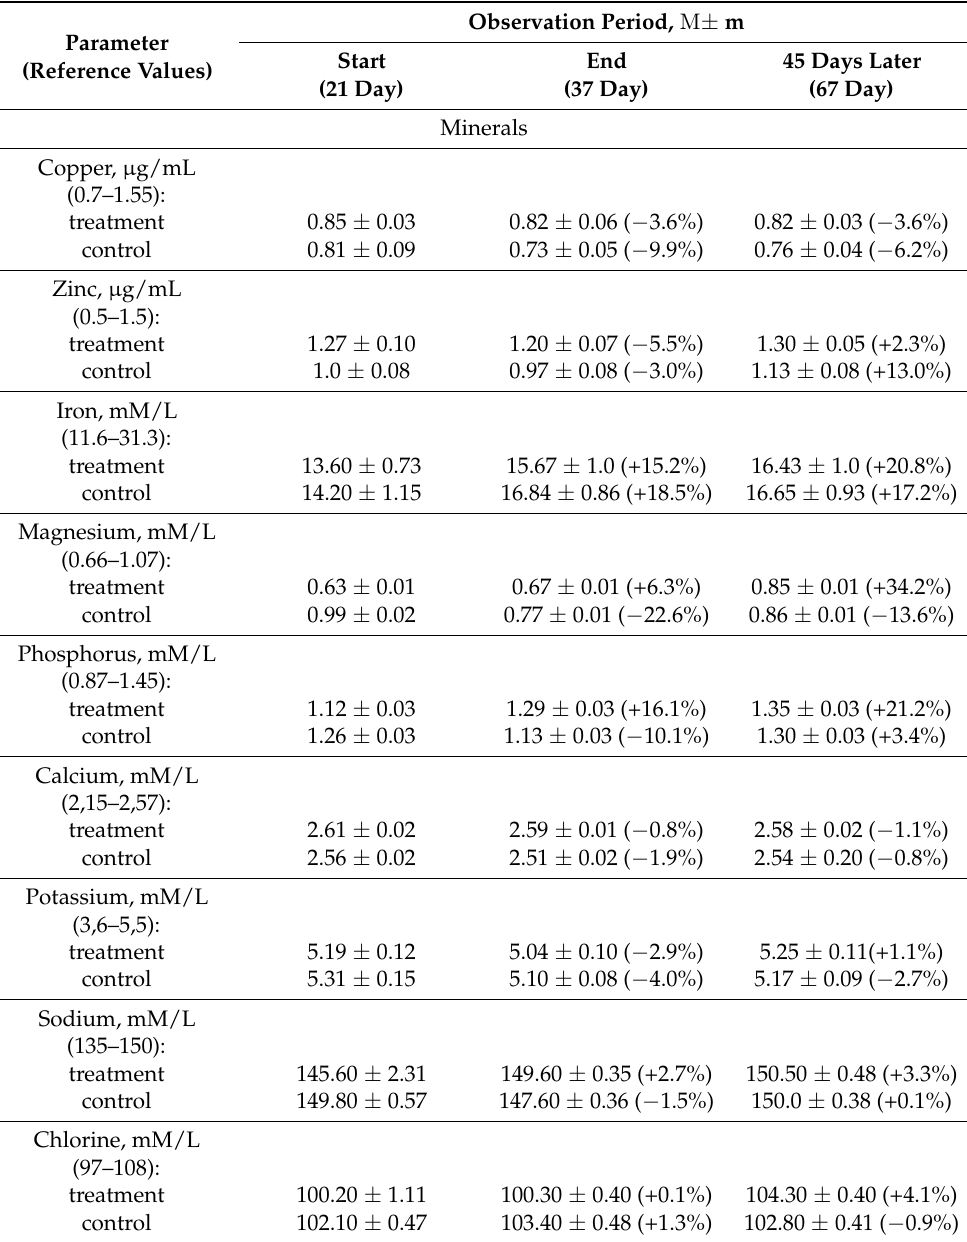
Table 2. Body mineral concentrations during the observation period (absolute